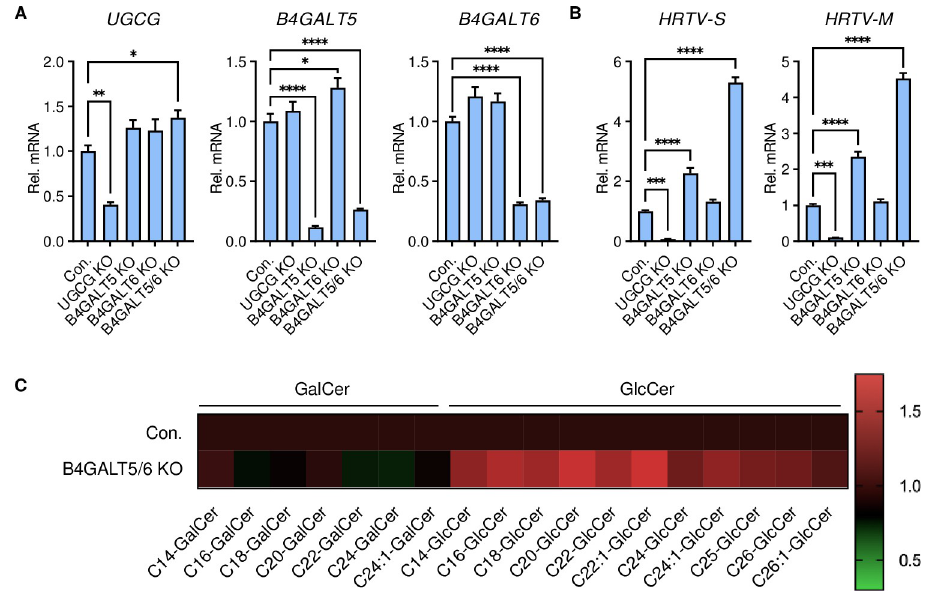
Fig 4. Glycosphingolipid downstream of GlcCer is not required for HRTV infection. A-B. Effect of B4GALT5-, B4GALT6- or B4GALT5/6 double-deficiency on HRTV replication. Control and KO 293T cells were infected with HRTV (MOI = 1) for 24 hours, followed by qPCR analysis. Data shown are means ± SEM from representative experiments (n = 3 technical replicates). P values were determined by ordinary one-way ANOVA with Dunnett’s multiple comparison tests. ���� , P < 0.0001; ��� , P < 0.001; �� , P < 0.01; � , P < 0.05. C. Heat map of the levels of intracellular GalCer and GlcCer in control or B4GALT5/6 double knockout 293T cell lines.